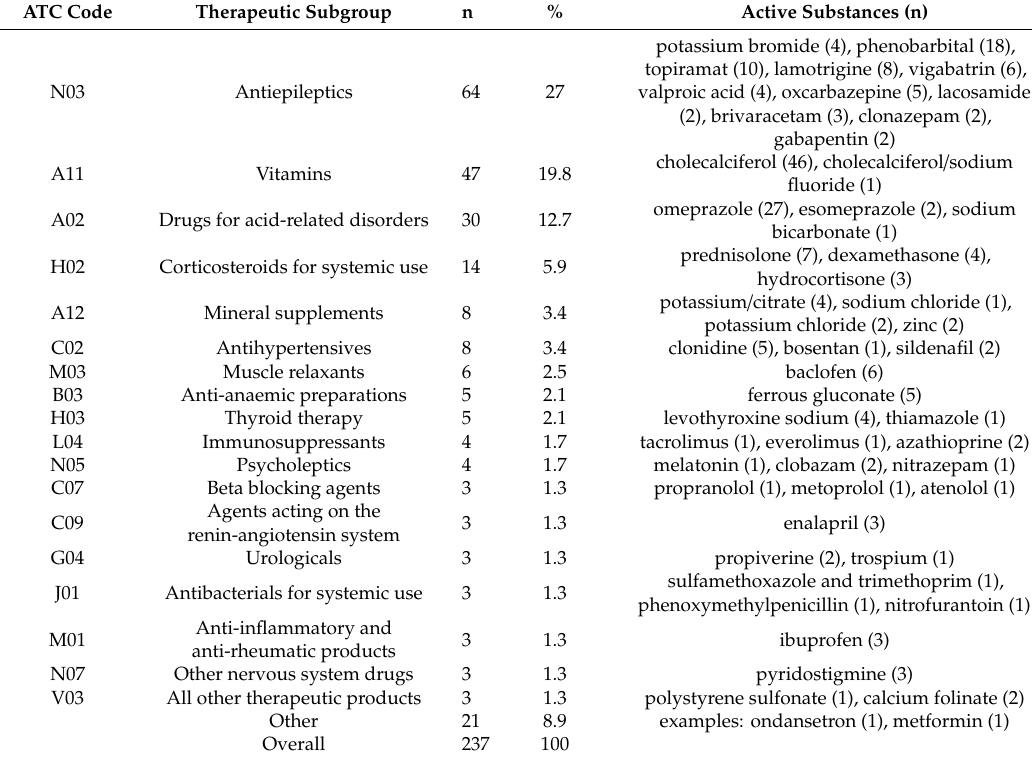
Table 3. Therapeutic subgroup of manipulated active substances classified by ATC code